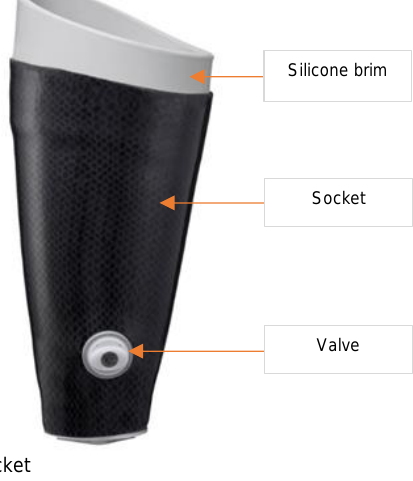
Figure 1: Direct Socket